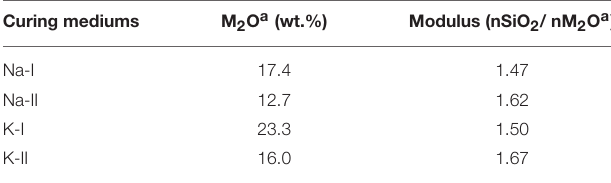
TABLE 2 | The alkali content and modulus of the four curing